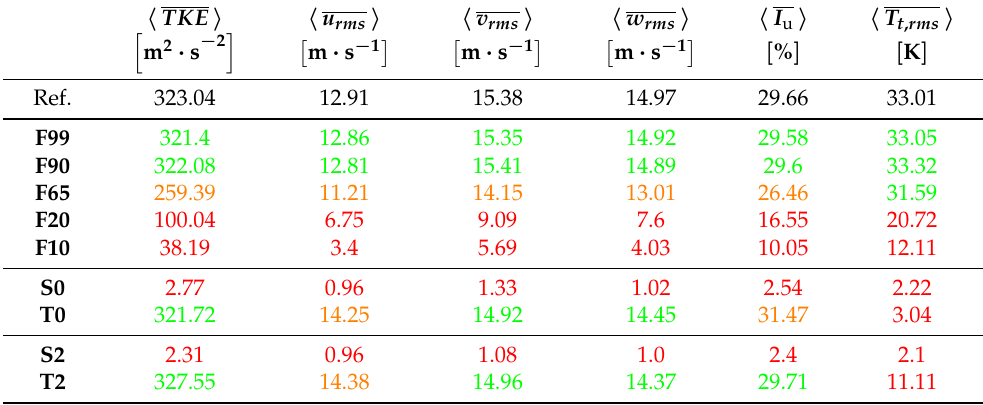
Table 4. Spatial average of TKE, velocity RMS, total temperature RMS, and turbulent intensity at plane 40. The color of the values are determined by their relative difference compared to the reference: Green for relative differences lower than 5%, orange between 5% and 20%, and red for relative differences greater than 20%. The reference corresponds to the integrated combustor/turbine simulation.